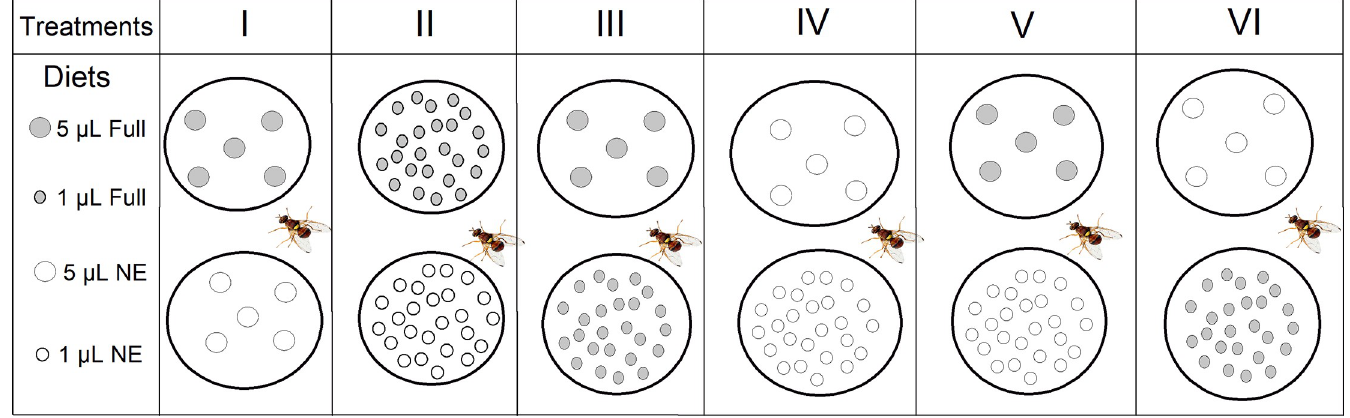
Fig 1. Experimental arenas of the effect of diet quality and density on foraging decisions by the oriental fruit fly Bactrocera dorsalis . Full diets contain all amino acids, and NE diets contain only the non-essential amino acids.